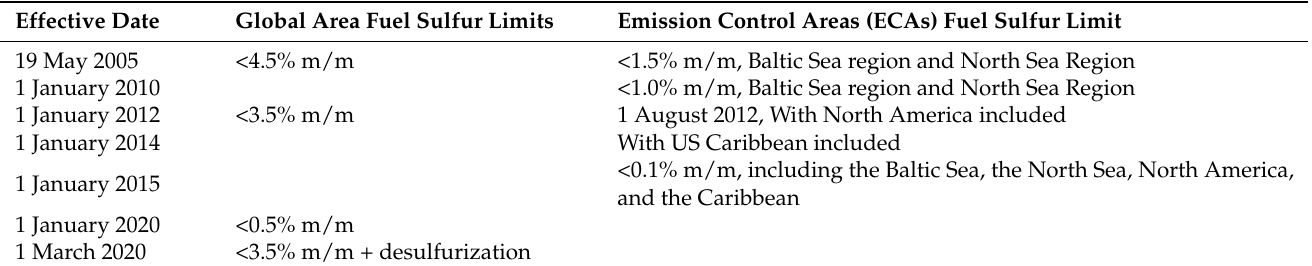
Table 1. Chronological evolution of IMO fuel sulfur regulations in maritime